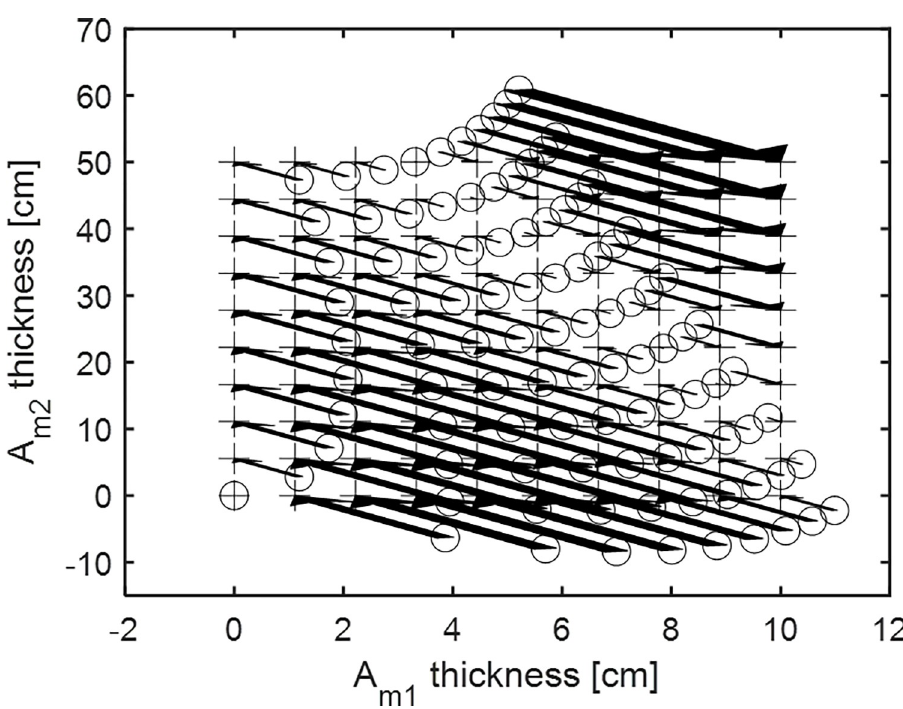
Fig 2. The error correction LUT is calculated from the MD calibration process. The circles represent A the crosses represent A calib . The arrows represent the error correction values δ A for various material